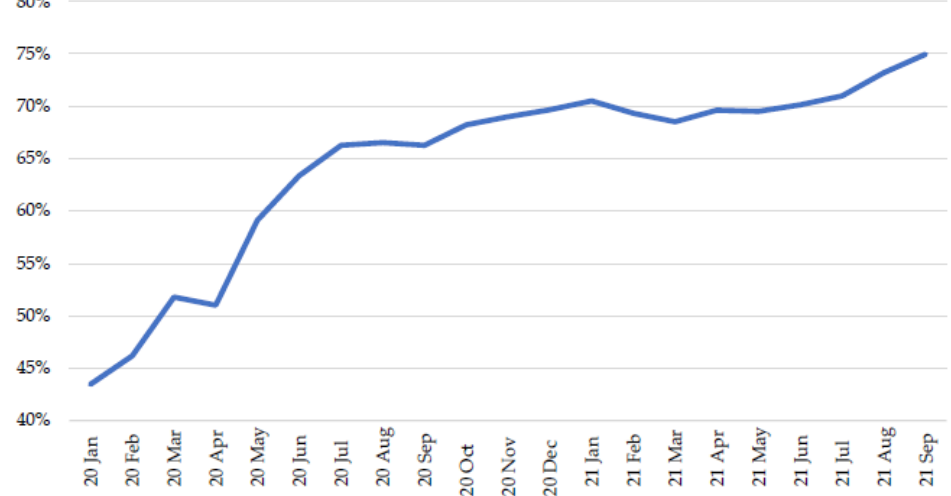
Figure 1. National Share of Beds in Use. Source: (COVID-19 Reported Patient Impact and Hospital Capacity by State Timeseries 2021).